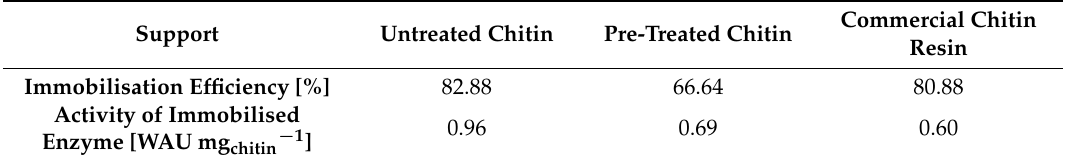
Table 4. Effect of different kinds of chitin on immobilisation efficiency and catalytic efficiency of